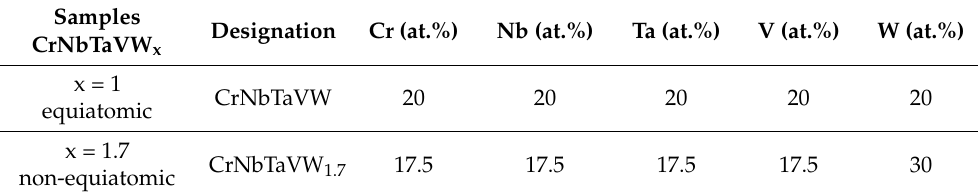
Table 1. Atomic percentage of each element in all samples and the respective designation.